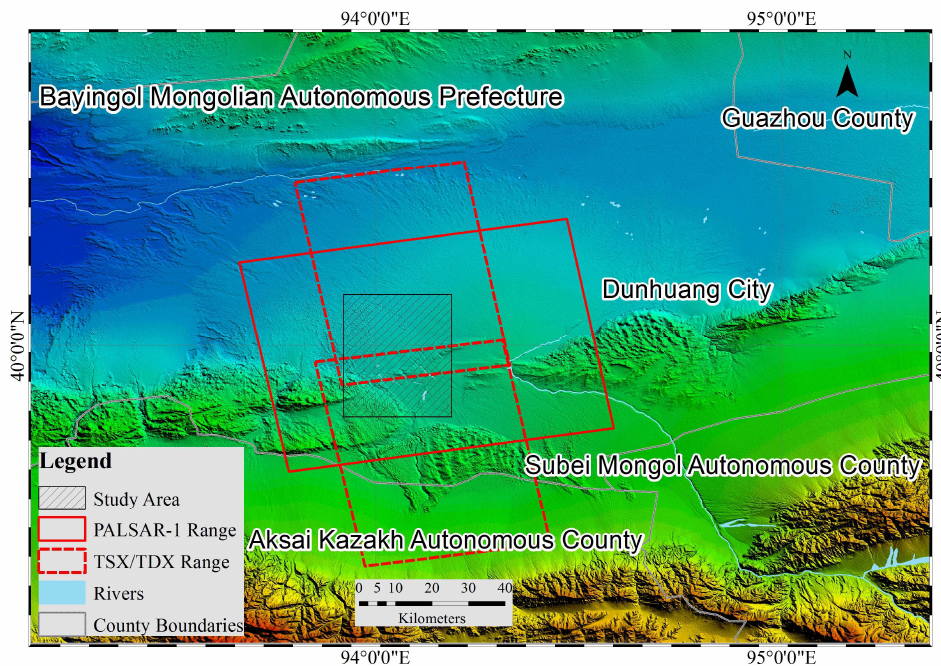
Figure 2. Distribution of the SAR images in the study area. Six frames of PALSAR-1 archived time-series data (rectangle with solid red outline) and two frames of TSX/TDX data (rectangles with dotted red line) covering the entire Nanhu oasis study area (black rectangular frame with faint lines).